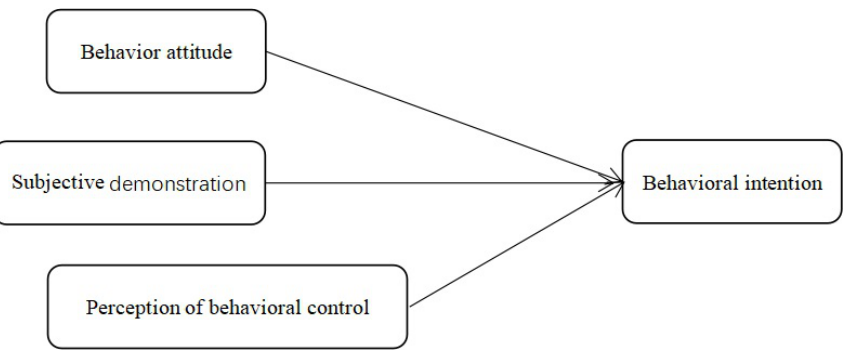
Fig. 1 Individual authenticity